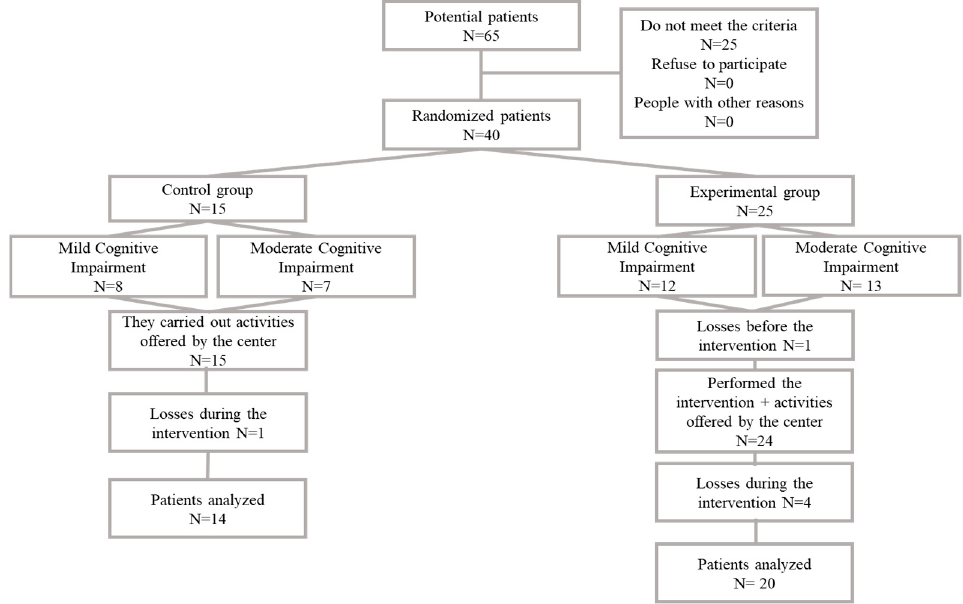
Figure 1. Flow diagram. Table 2. Initial comparison between CG and EG. Table 1. Sample